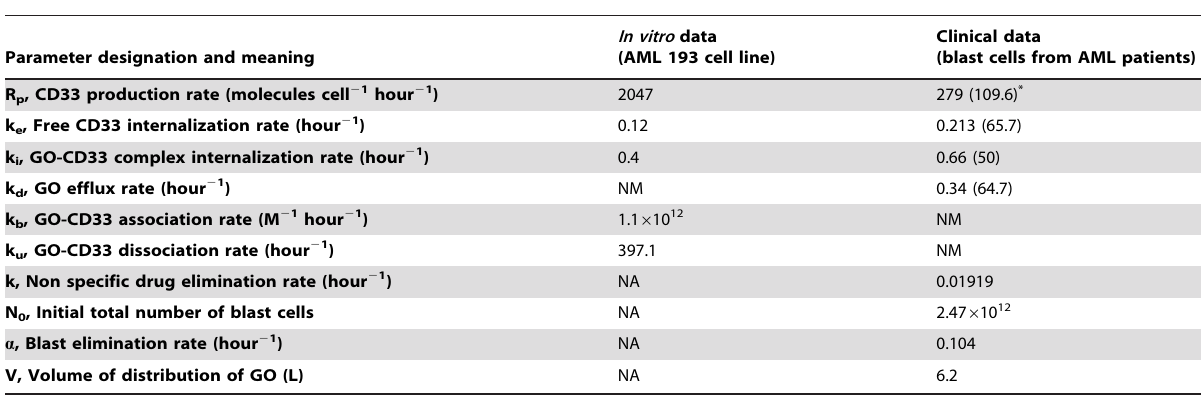
Table 1. Estimates of the model